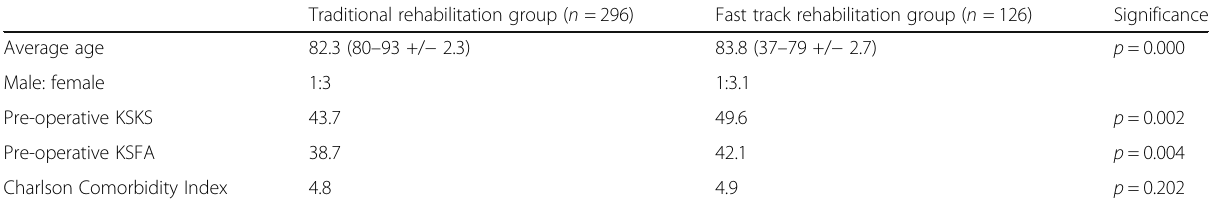
Table 3 The baseline characteristics of the elderly patients in both the traditional rehabilitation and fast track rehabilitation groups Traditional rehabilitation group ( n =